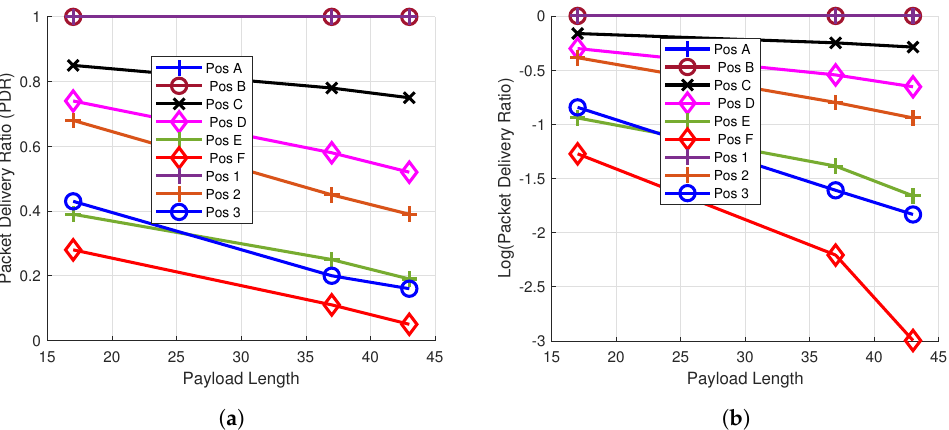
Figure 9. ( a ) PDR vs. payload length for SF12, CR = 4/5, BW = 125 KHz @ 868 MHz ( b ) log(PDR) vs. payload length for